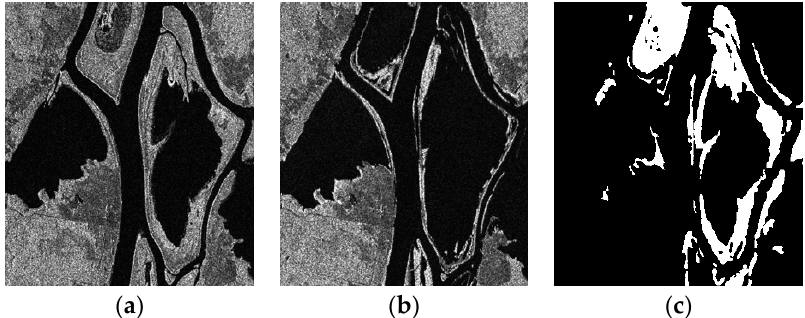
Figure 4. Ottawa data set: ( a ) Image acquired in May 1997; ( b ) Image acquired in August 1997; ( c ) The reference change image.